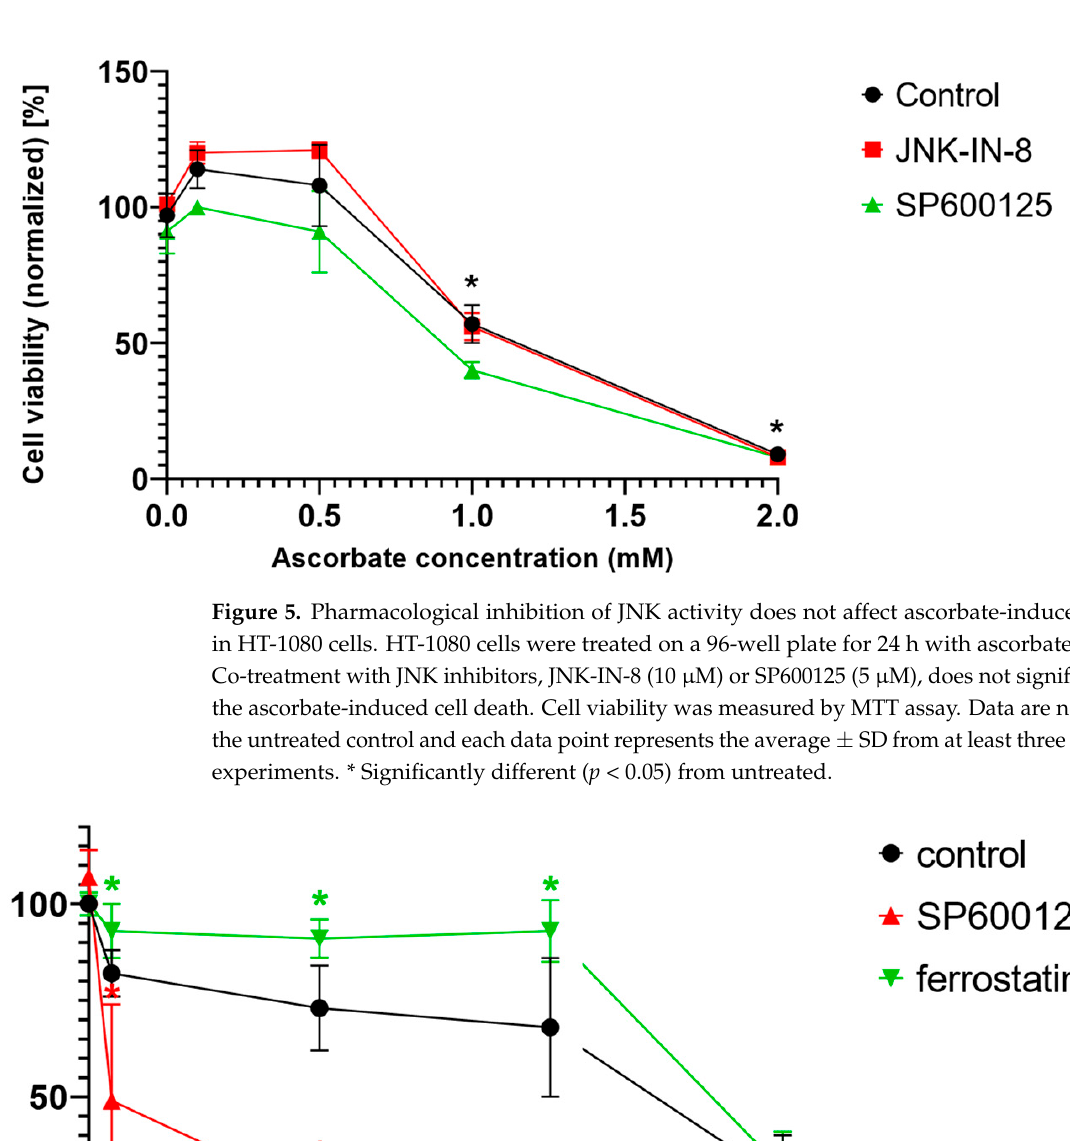
Figure 5. Pharmacological inhibition of JNK activity does not affect ascorbate-induced cell death in HT-1080 cells. HT-1080 cells were treated on a 96-well plate for 24 h with ascorbate (0.1–2 mM). Co- treatment with JNK inhibitors, JNK-IN-8 (10 µM) or SP600125 (5 µM), does not significantly affect the ascorbate-induced cell death. Cell viability was measured by MTT assay. Data are normalized to the untreated control and each data point represents the average ± SD from at least three inde- pendent experiments. * Significantly different ( p < 0.05) from untreated.